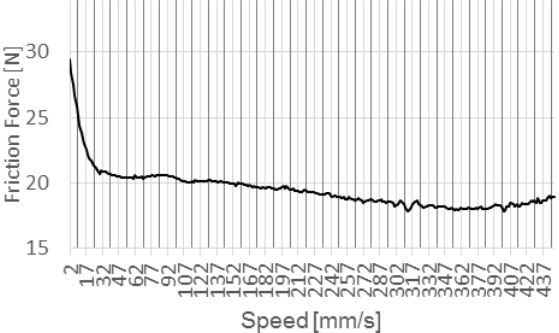
Fig. 6. The results of measuring the friction force as a function of speed